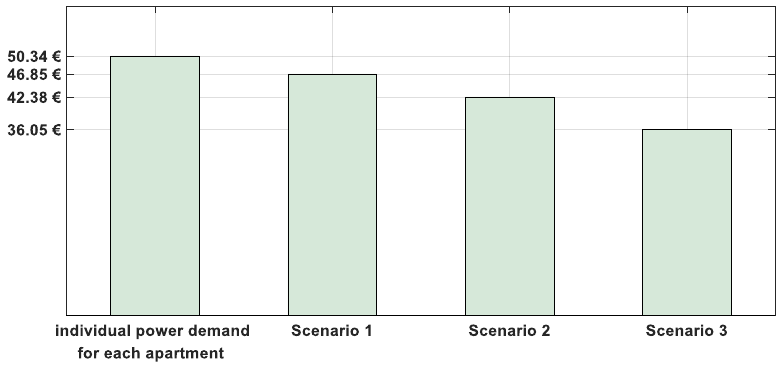
Figure 9. Billing comparison among the several scenarios.